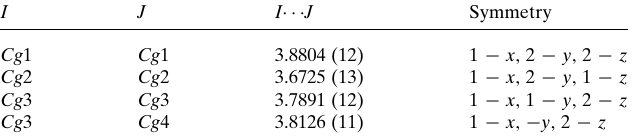
Table 2 Weak (cid:2) – (cid:2) interactions in compounds (I) and (II). Cg 1 and Cg 2 are the centroids of the C1–C6 and C18–C23 rings, respectively, in compound (I). Cg 3 and Cg 4 are the centroids of the C8–C13 and C1–C6 rings, respectively, in compound (II).